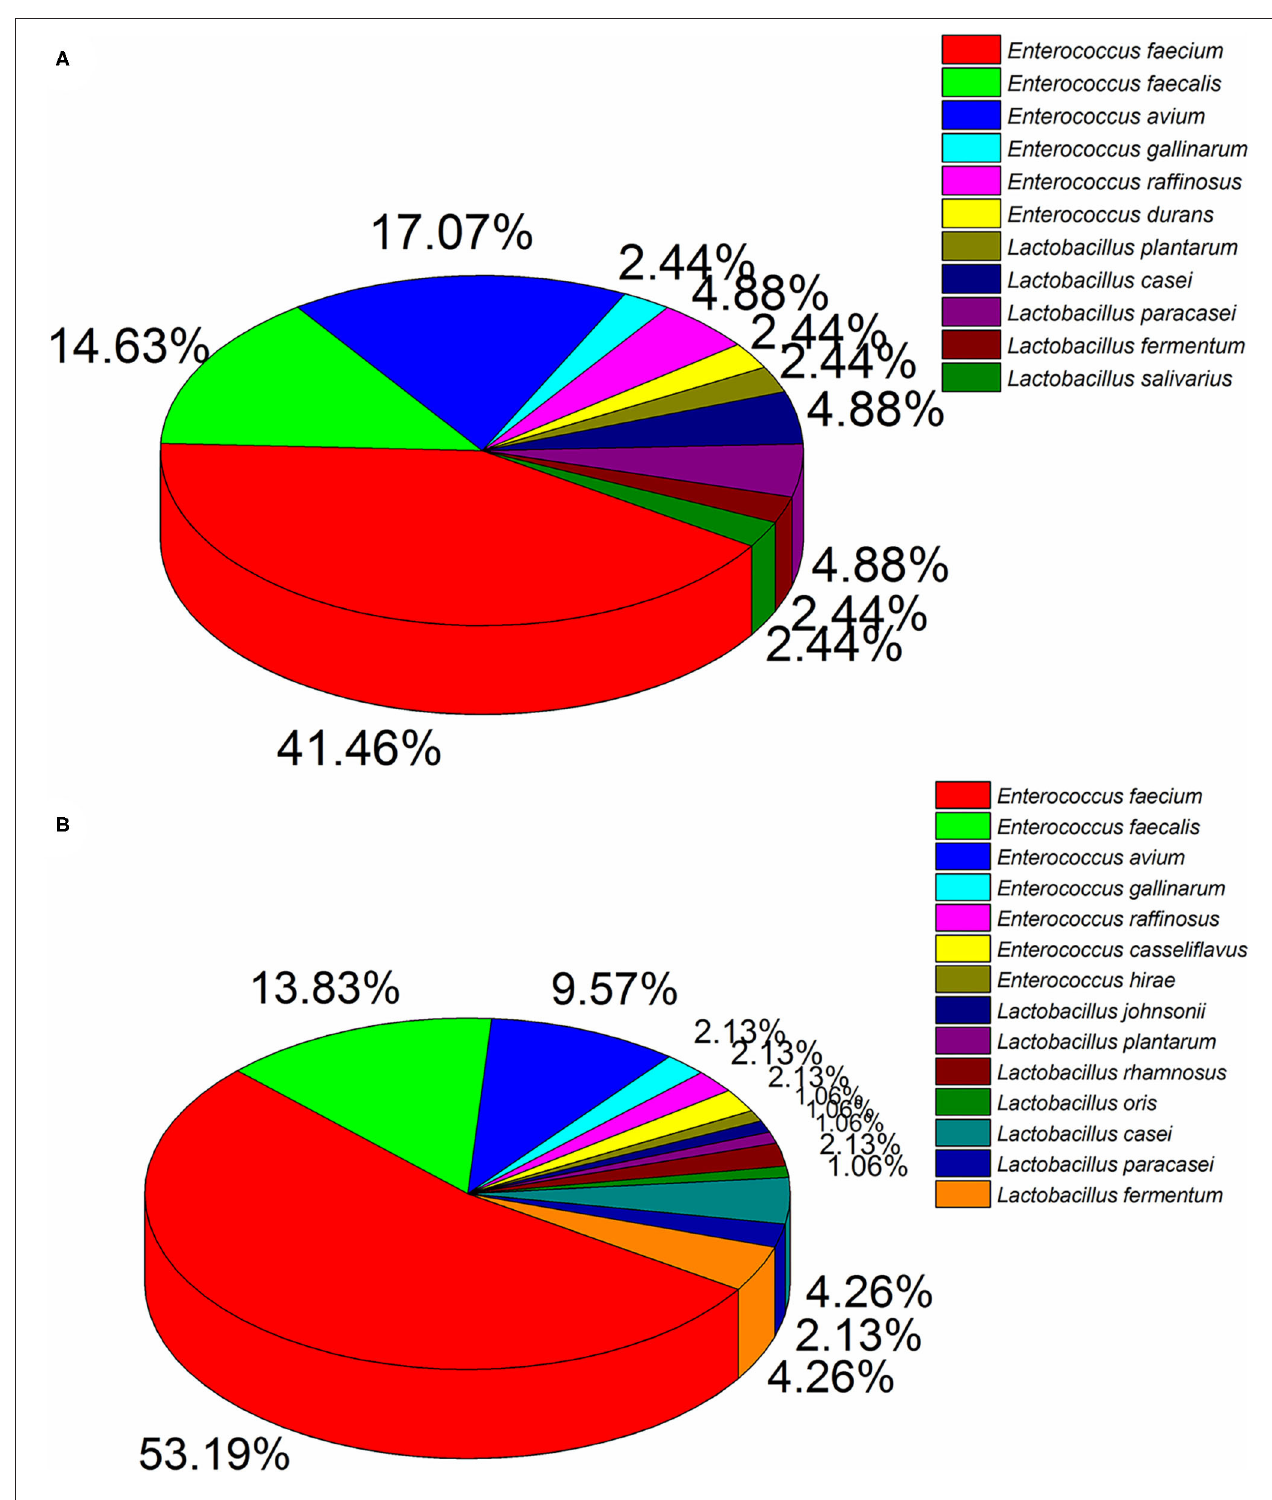
FIGURE 1 | Dominant LAB strains in healthy (A) and diarrhea (B) feces.